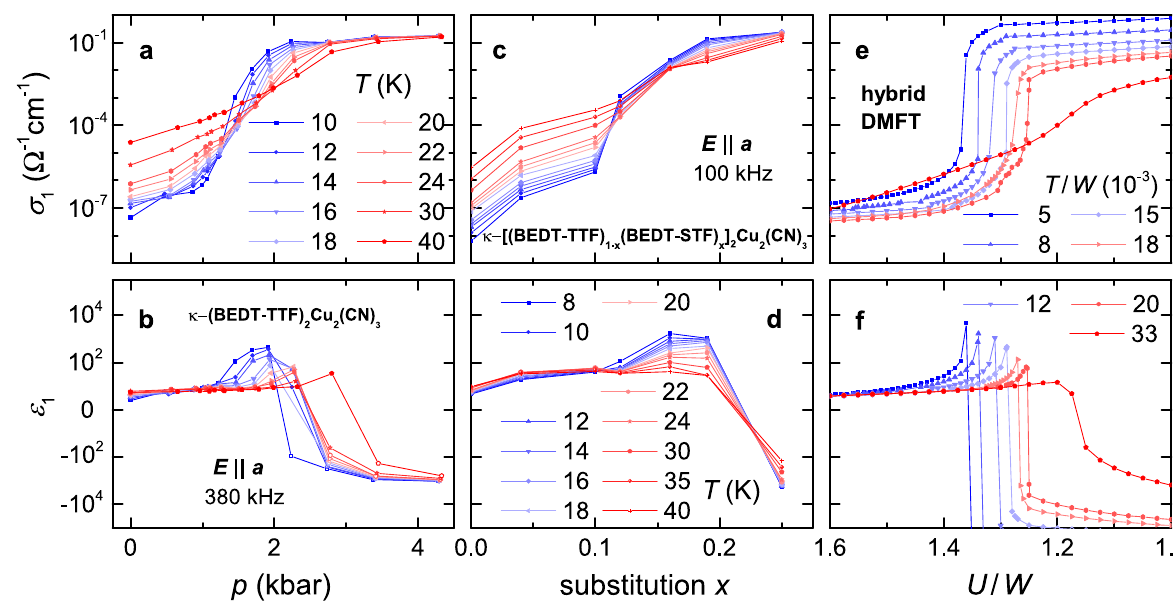
Fig. 3 Electrodynamics at the percolative Mott transition. a The Mott IMT of κ -(BEDT-TTF) 2 Cu 2 (CN) 3 appears as a rapid increase of σ 1 ( p ) that smoothens at higher T ; above T crit a gradual crossover remains. b ε 1 ( p ) exhibits a sharp peak below T crit . The results at f = 380 kHz are plotted on a logarithmic scale. c , d Similar behavior is observed for chemical BEDT-STF substitution x . e , f Fixed-temperature line cuts of our hybrid DMFT simulations (see text) as a function of correlation strength U / W and T / W 15,16 resemble the experimental situation in minute detail, including the shift of the IMT with T . The lack of saturation of σ 1 ( T → 0) seen in DMFT modeling re fl ects the neglect of elastic (impurity) scattering in the metal (outside the coexistence